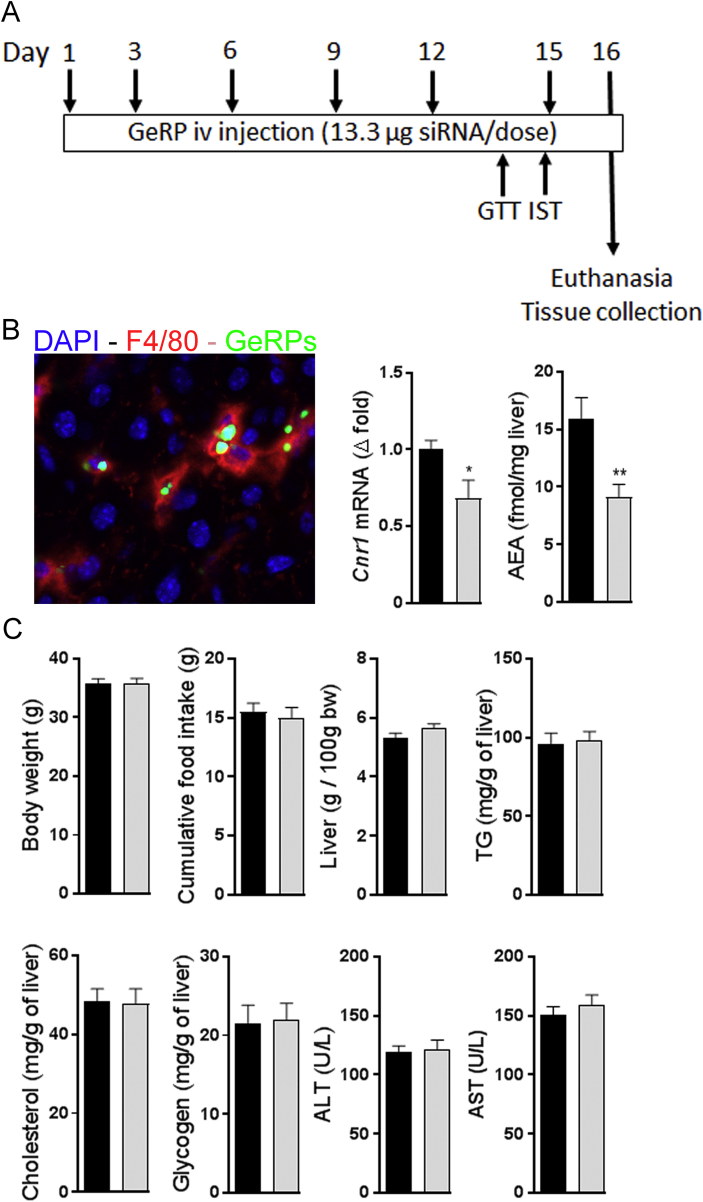
GeRP-mediated selective knock-down of Cnr1 in Kupffer cells in obese mice does not influence hepatic steatosis. A Protocol for 15-day GeRP treatment in obese mice. B KCs staining (red) in liver section from an obese mouse 24 h after intravenous injection with FITC-labeled GeRPs (green) (magnification ×200). Cnr1 gene expression and AEA content in liver from DIO mice treated with control (black columns, n = 10) or Cnr1-GeRPs (light grey columns, n = 10). C Body weight, cumulative food intake, liver weight, and liver TG, cholesterol, and glycogen content in obese mice treated with control or Cnr1-GeRPs. Columns and bars represent means ± SEM. Significant differences from values in control-GeRPs treated obese mice *P < 0.05, **P < 0.01, ***P < 0.001.